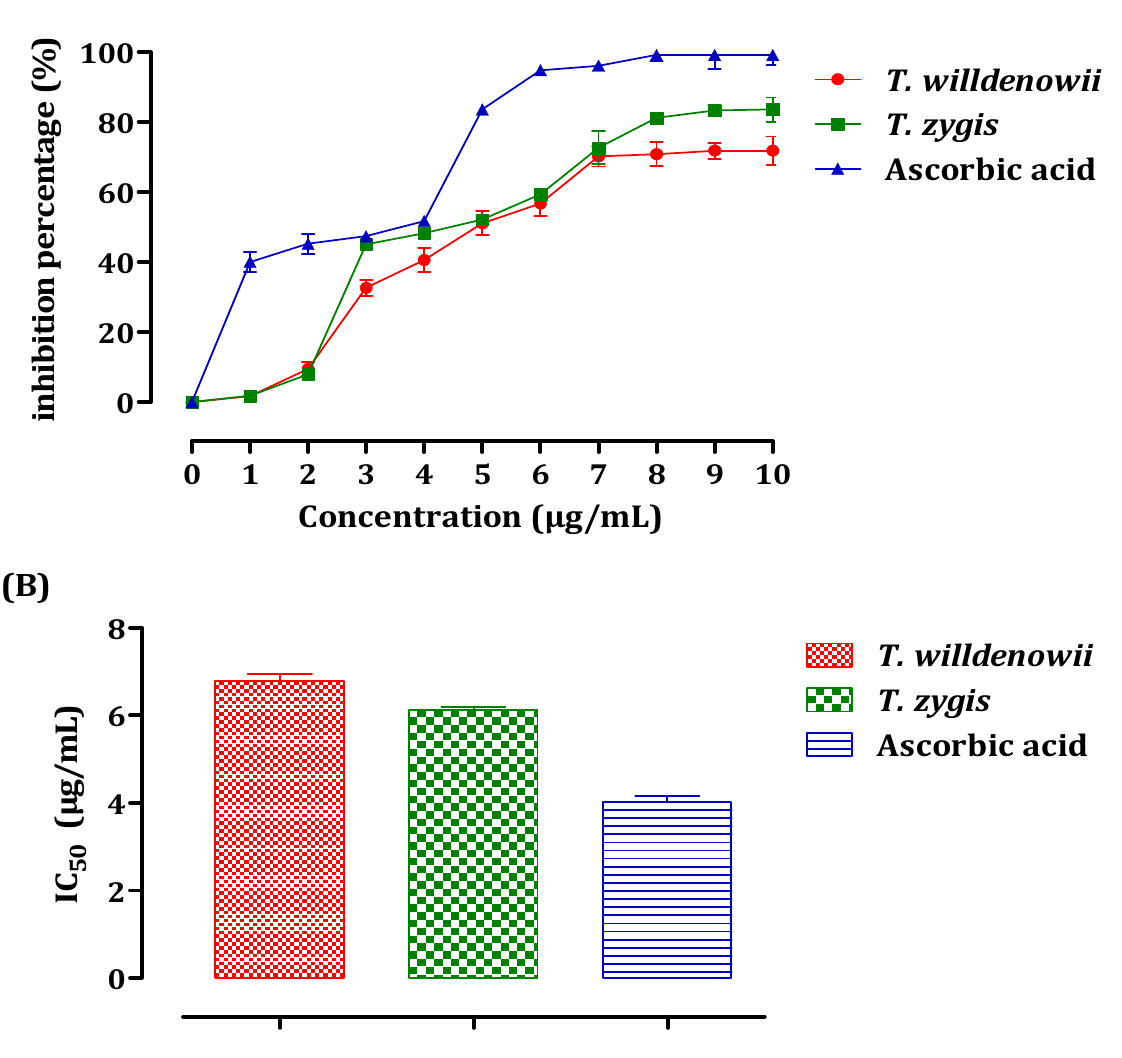
Figure 3. DPPH Free radical scavenging activity of T. zygis , T. willdenowii , and ascorbic acid. Inhibitory percentage ( A ) and IC 50 ( B ) against the DPPH Free radical. data are presented as mean ± SD, the experiment was performed in a minimum of 2 replicates T. zygis : Thymus zygis , T. willdenowii : Thymus willdenowii.